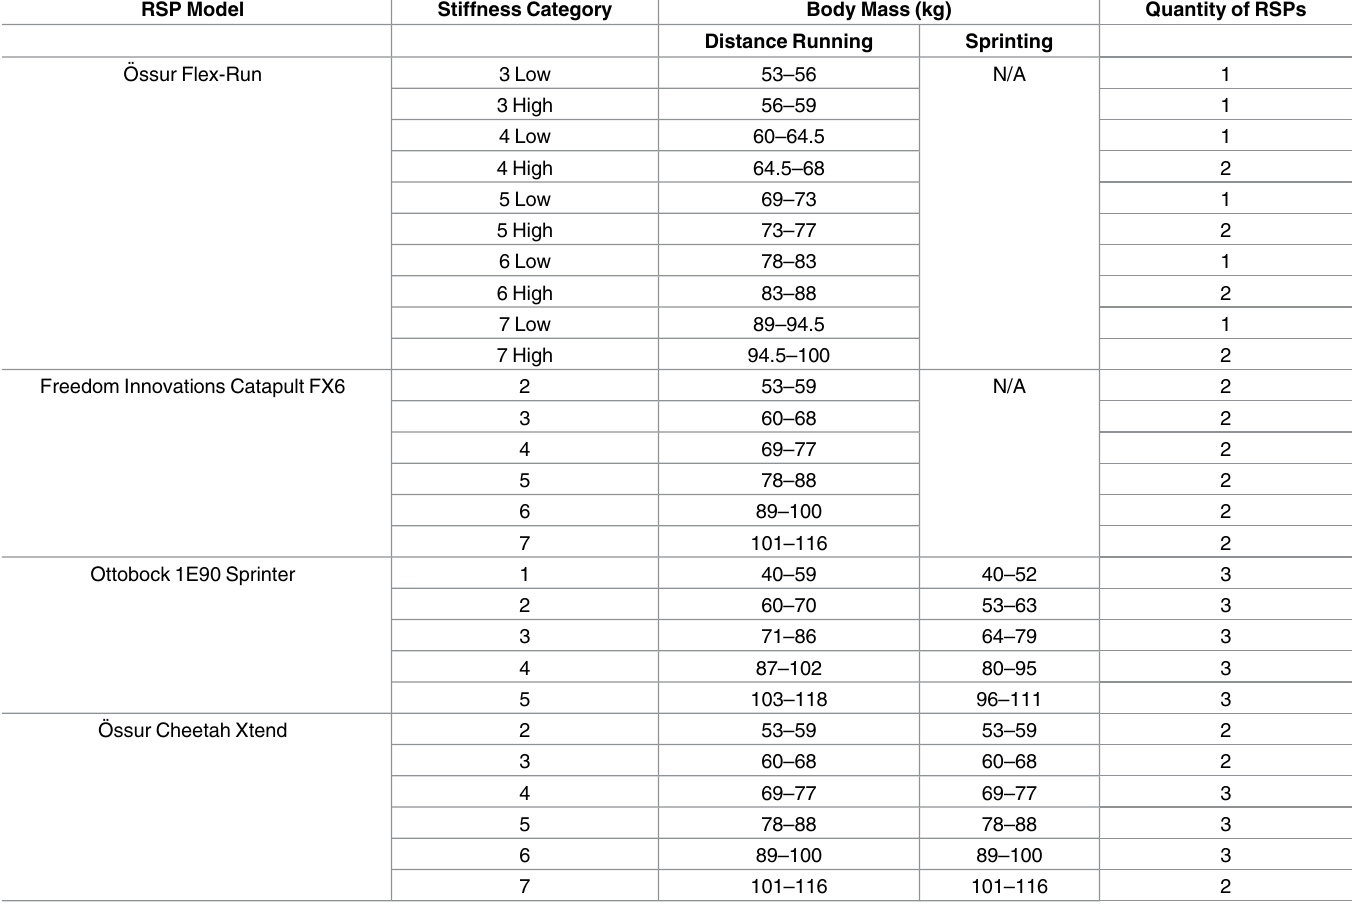
Table 1. The manufacturer recommended running-specific prosthesis (RSP) stiffness categories with the corresponding body mass for distance running and sprinting, plus the quantity of RSPs tested. RSP Model Stiffness Category Body Mass (kg) Quantity of RSPs Distance Running Sprinting O¨ ssur